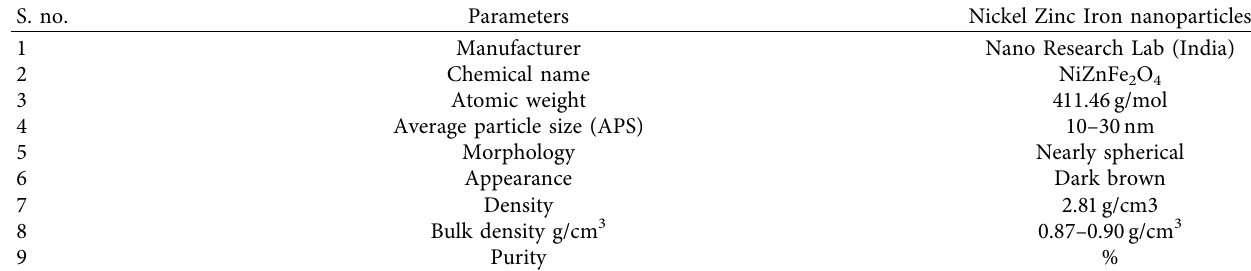
2 O 4 ) nanoparticles physical properties.